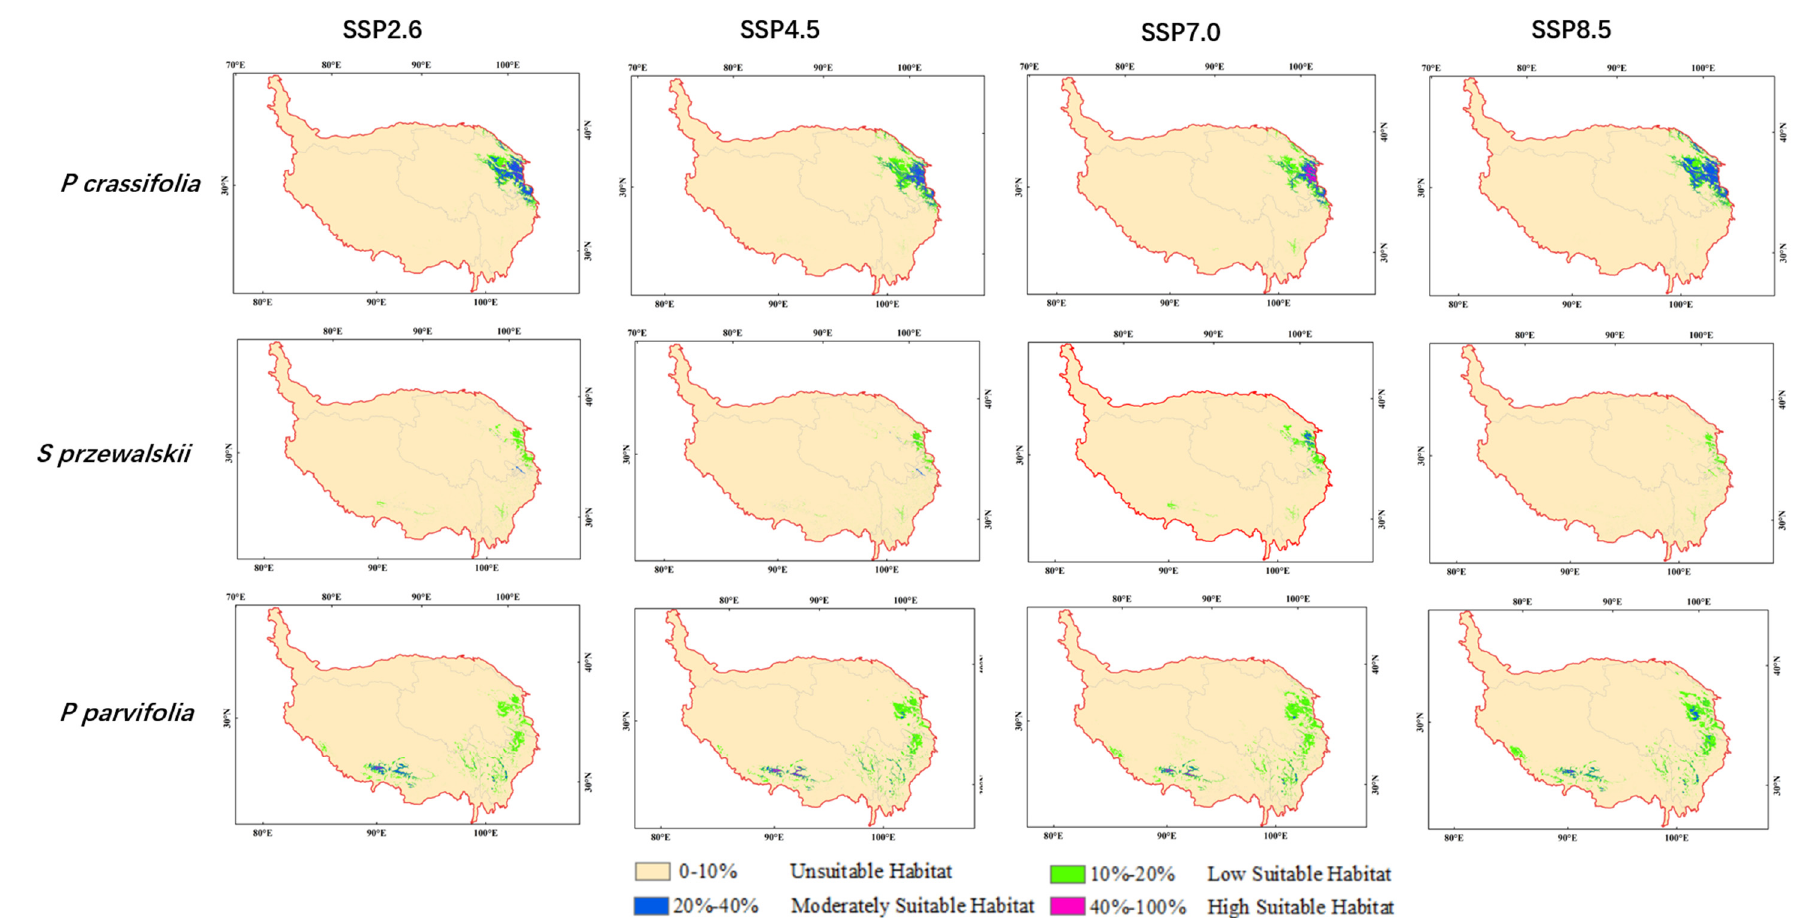
Figure 5. Prediction results of potential geographical distribution of three species in 2070s.